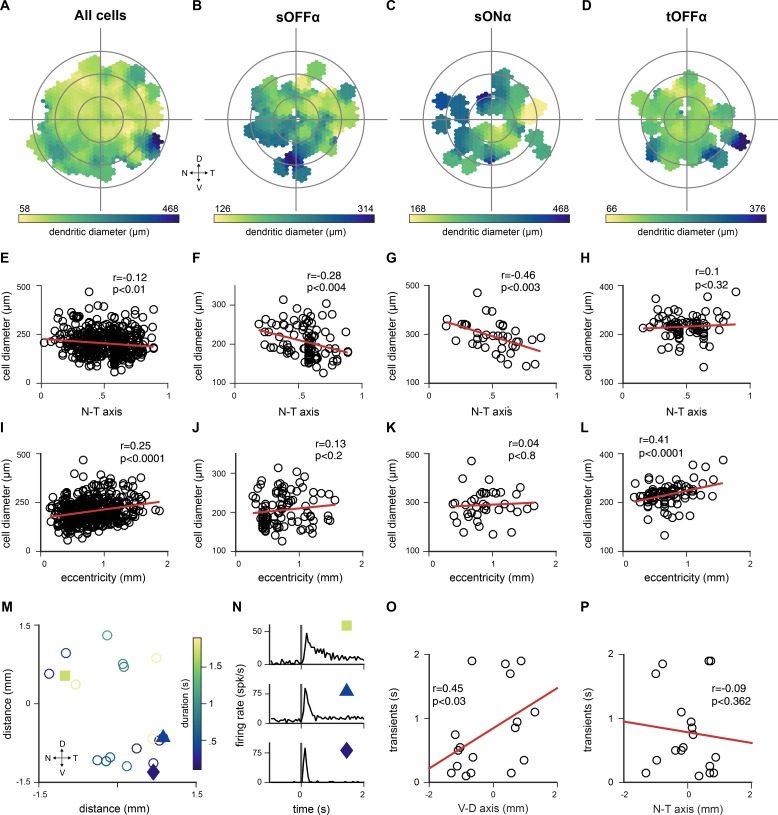
Spatial distribution of cell types across the retina confirms correct classification.(A–D) Distribution of dendritic field diameter of all labeled cells (A), sustained OFF (sOFF) alpha cells from cluster 1 (B), sustained (sON) alpha cells from cluster 13 (C) and transient OFF (tOFF) alpha cells from cluster 6 (D) at their retinotopic location. (E–H) Dendritic field diameter of all labeled cells (E), sOFF-alpha cells (F), sON alpha cells (G) and tOFF-alpha cells (H) are plotted along the nasal - temporal axis. sOFF- and sON-alpha cells showed negative correlation (sOFF: r = −0.28, p<0.004; sON: r = −0.46, p<0.003; two-tailed Pearson correlation coefficient test). (I–L) Dendritic field size of all labeled cells (I), sOFF-alpha cells (J), sON-alpha cells (K) and tOFF-alpha cells (L) relative to eccentricity (from optic nerve to periphery). tOFF-alpha cells and the whole labeled cell population showed positive correlation (tOFF: r = 0.41, p<0.0001; all cells: r = 0.25, p<0.0001; two-tailed Pearson correlation coefficient test) M) Positions of 18 labeled retinal ganglion cells that were assigned to the tOFF-alpha cell group. D, dorsal; V, ventral; T, temporal; N, nasal. Color bar indicated response duration time. (N) Mean responses of 3 representative retinal ganglion cells from the tOFF-alpha cell group, whose locations are indicated in M. (O–P) Response durations are plotted across the ventral-dorsal axis (O) and nasal-temporal axis (P). Response transients gradually change along the ventral – dorsal axis (r = 0.45, p<0.03, Pearson correlation coefficient test).